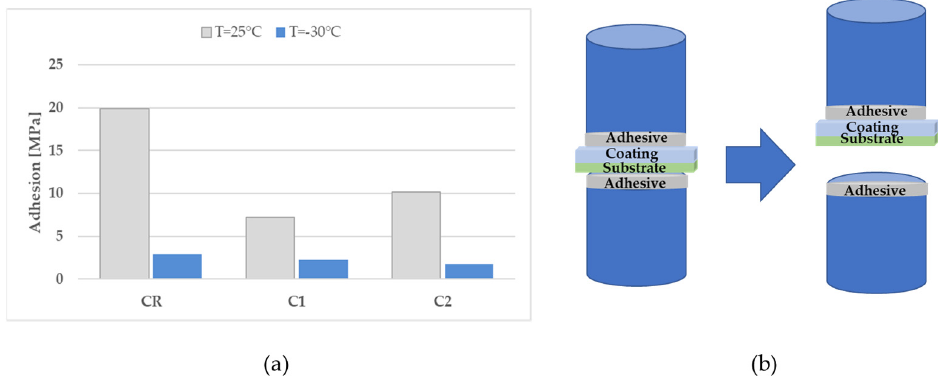
Figure 11. Adhesion test results performed on C samples at 25 °C and − 30 °C ( a ); schematic draw of most adhesion failures occurred during the testing of C samples ( b ).